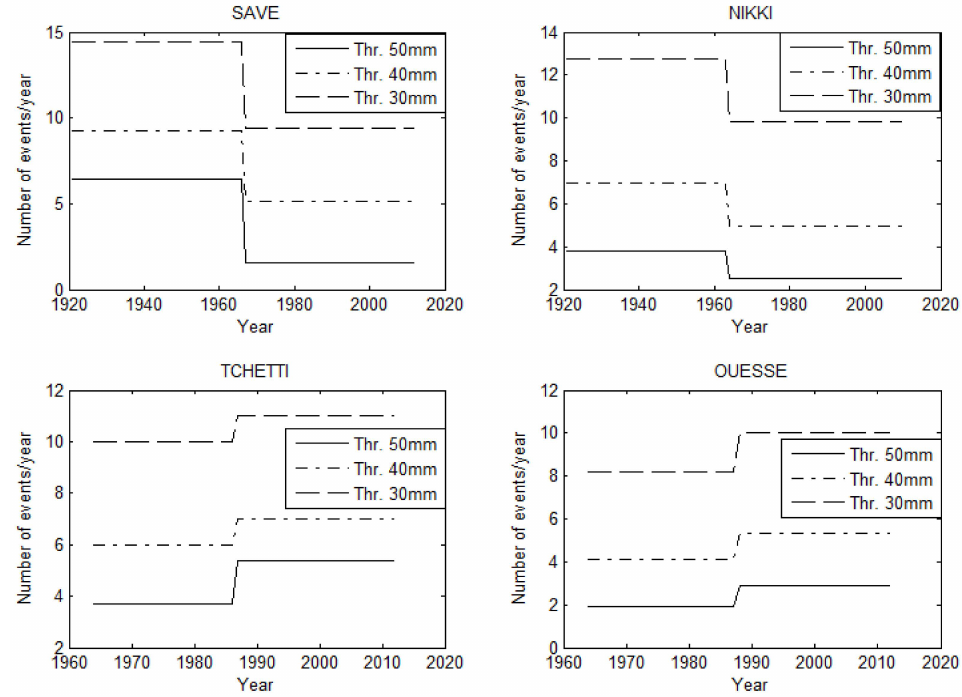
Figure 6. Mean number of days with rainfall greater or equal to 50, 40 and 30 mm per year at Savè, Nikki, Tchètti and Ouèssè stations for two sub periods used in computed